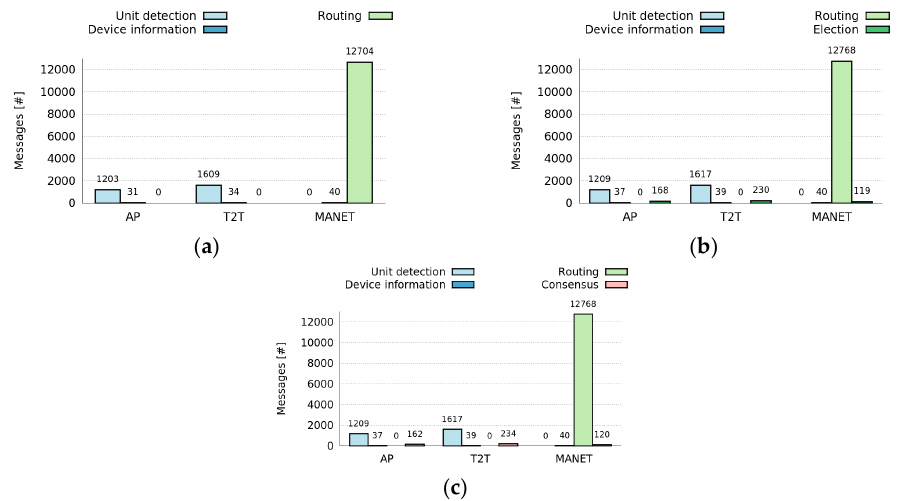
Figure 9. Cost of the different role architectures of the Control Tier for different network architectures. ( a ) Fixed Centralized; ( b ) Dynamic Centralized; ( c ) Distributed.